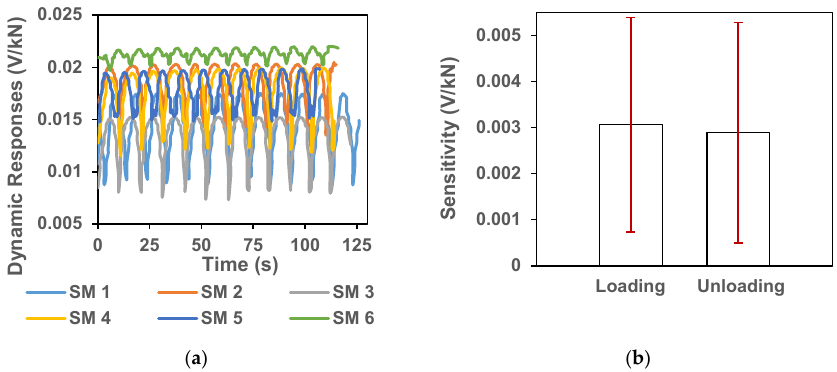
Figure 7. ( a ) Dynamic load responses in sample blocks impregnated with 0.1% SM-CNTs. The multiple plots represent responses from each sample from group SM; ( b ) Average loading and unloading sensitivities in sample blocks impregnated with 0.1% CCNTs. The vertical error bars represent the standard